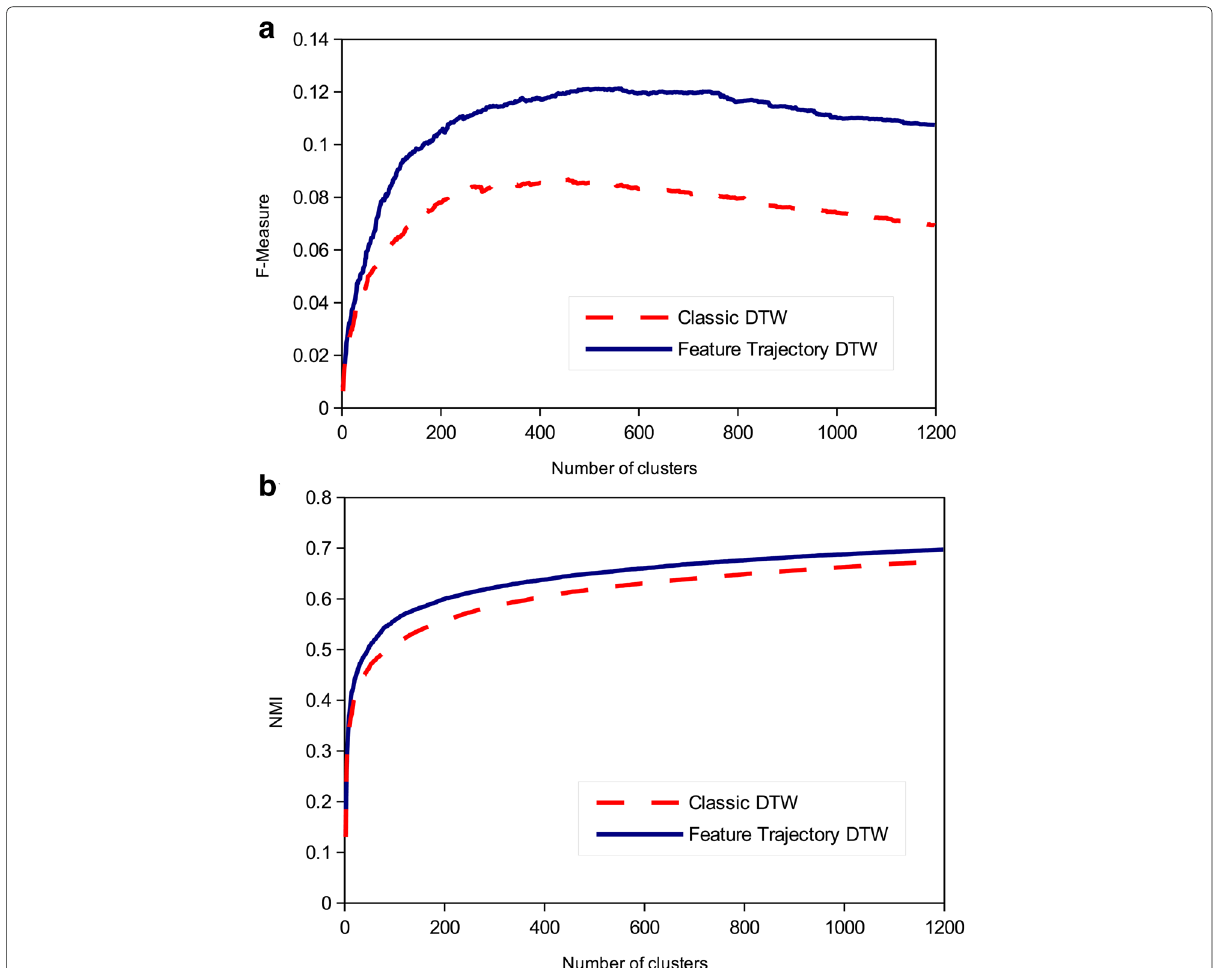
Fig. 4 Clustering performance for dataset 1 when using PLP features in terms of a F-measure and b